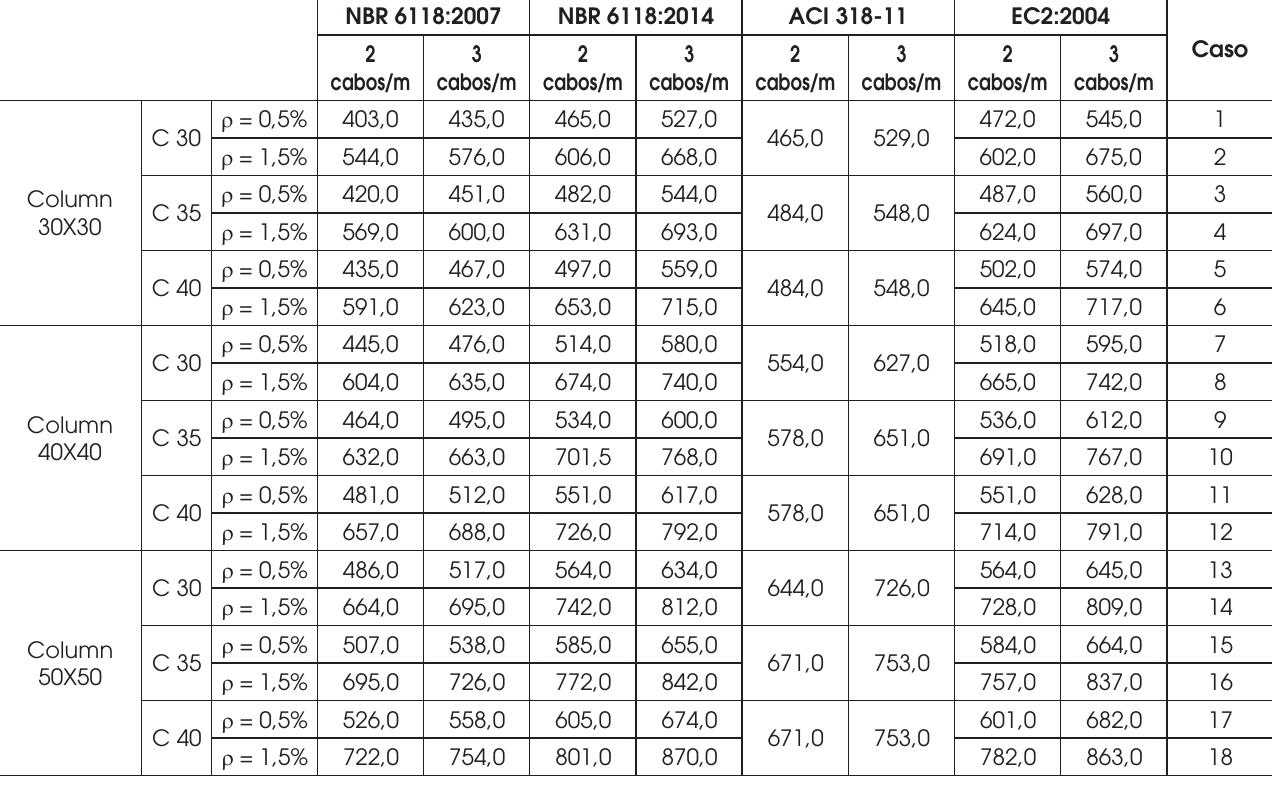
Maximum factored shear force